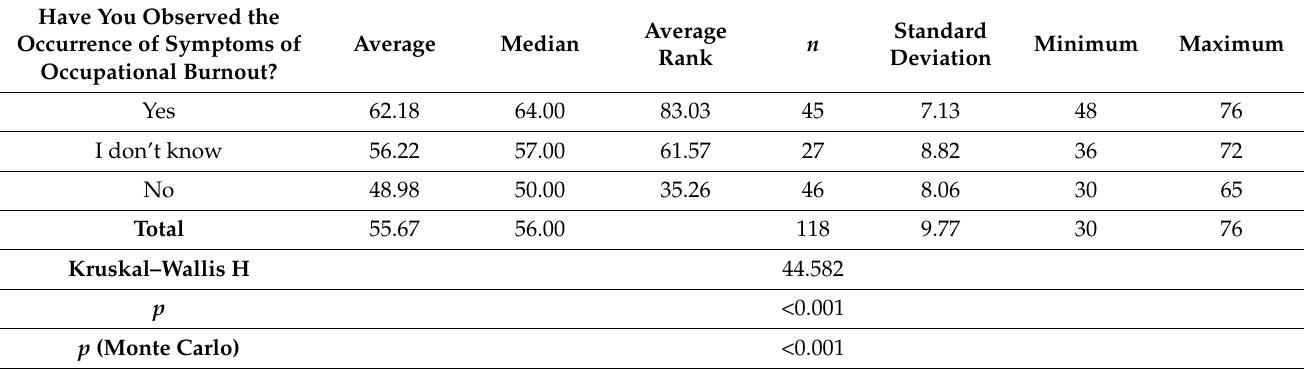
Table 4. Respondents’ subjective opinion on the occurrence of occupational burnout.